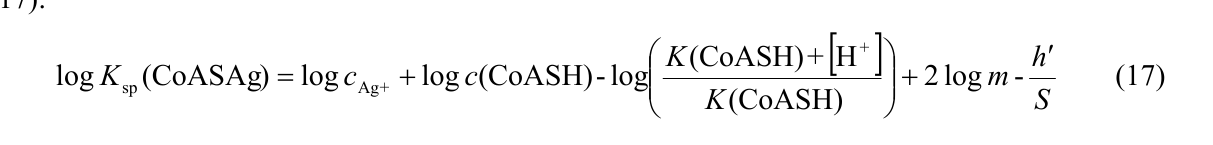
Table 1. Comparation of p K